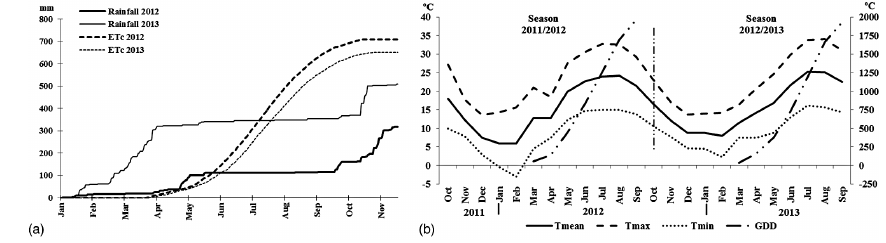
Figure 4. (a) Accumulation of rainfall and ETc of 2012 and 2013 growing seasons. (b) Temperature components recorded in both 2012 and 2013 growing seasons: Tmean, Tmax and Tmin are monthly average, maximum and minimum temperature respectively; GDD is the growing degree day reached the last day of the month.